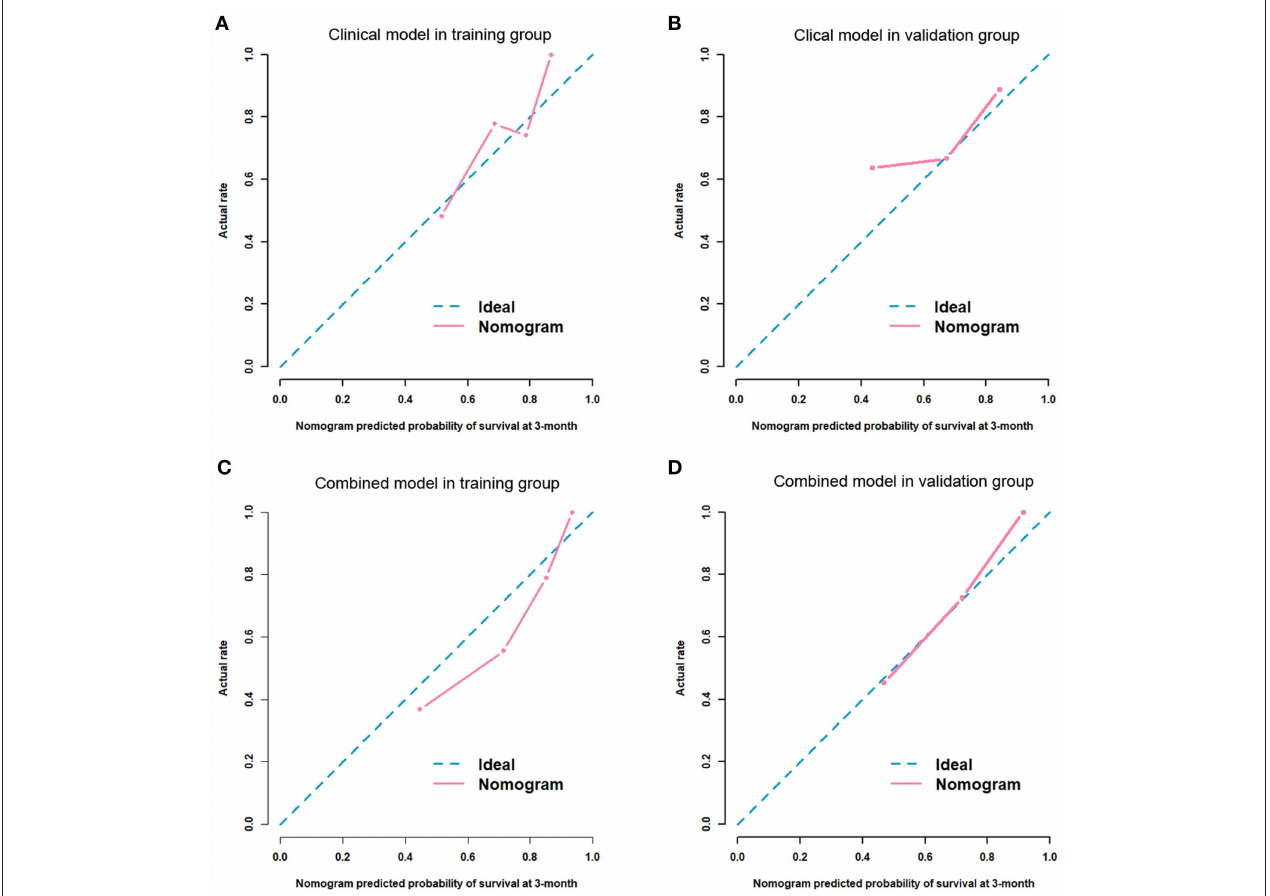
FIGURE 4 | Calibration curves for the predictive performance for 3-month RFS. Clinical model in the training group ( A , p = 0.105) and the validation group ( B , p = 0.343). Combined model in the training group ( C , p = 0.823) and the validation group ( D , p = 0.329).